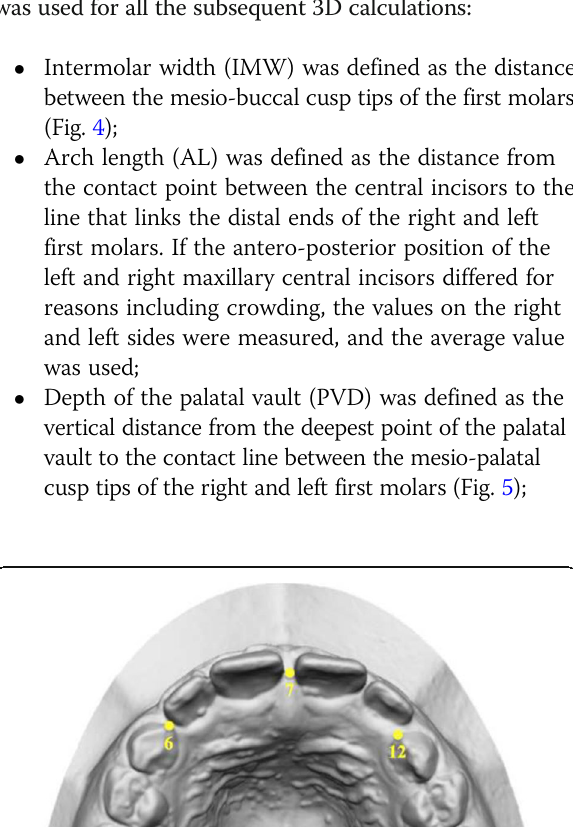
Fig. 1 Diagrammatic representation of the most common sectors of the impacted canine [5]